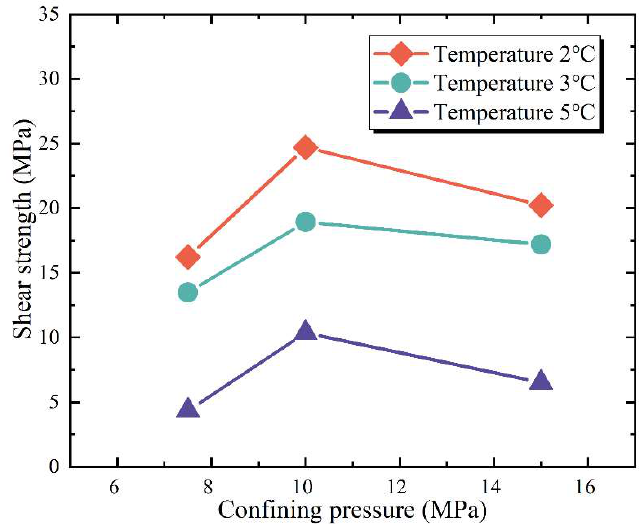
Figure 8. Shear strength at different confining pressures.